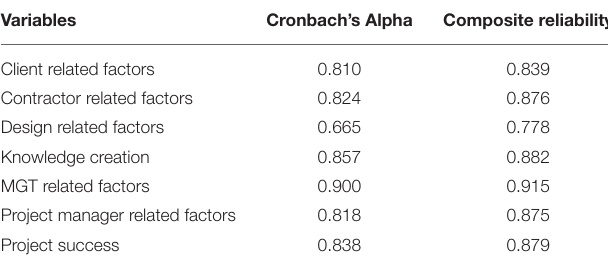
TABLE 5 | Respondent profile. TABLE 6 | Internal consistency of the final